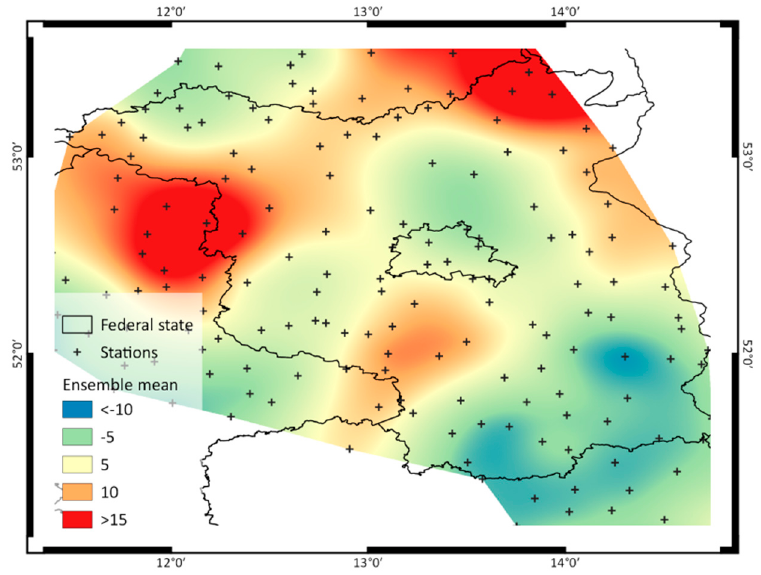
Figure 9. Percent change in the R factor 2041–2065 compared to 2001–2015 for a moderate climate change (RCP 4.5), using the bias-corrected ensemble subset and the average of Equations (2) and (3). Values interpolated with thin splines. The overall change for this combination is close to 0%.